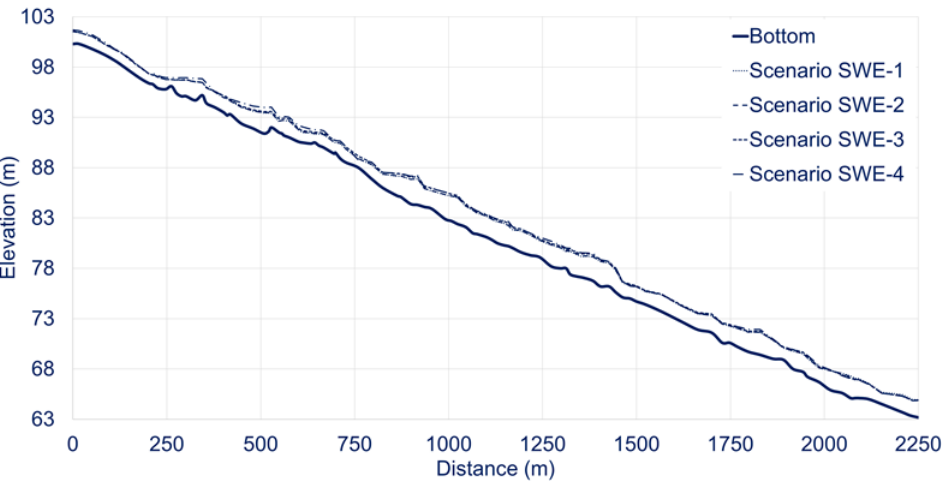
Figure 4. Comparison of water elevations along Koropouli Street for the SWE scenarios.